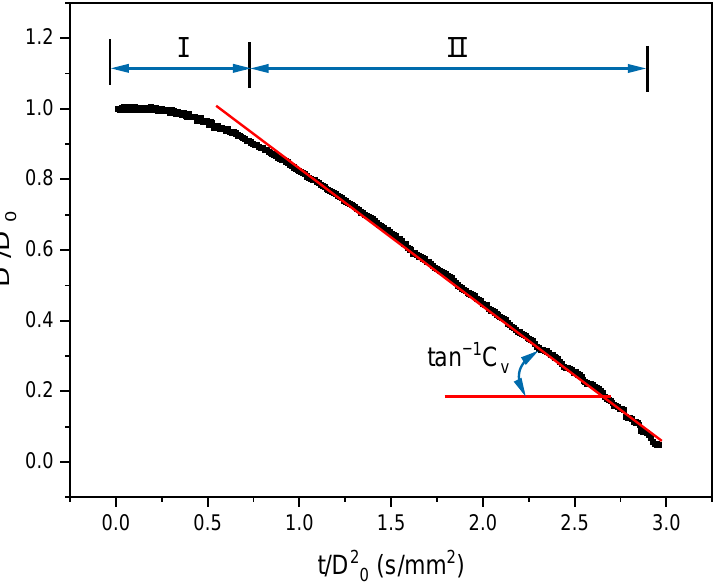
Figure 2. Temporal variation of the normalized D 2 at 0.4 bar and 773 K. (I: Nonlinear stage; II: d 2 -law evaporation stage).